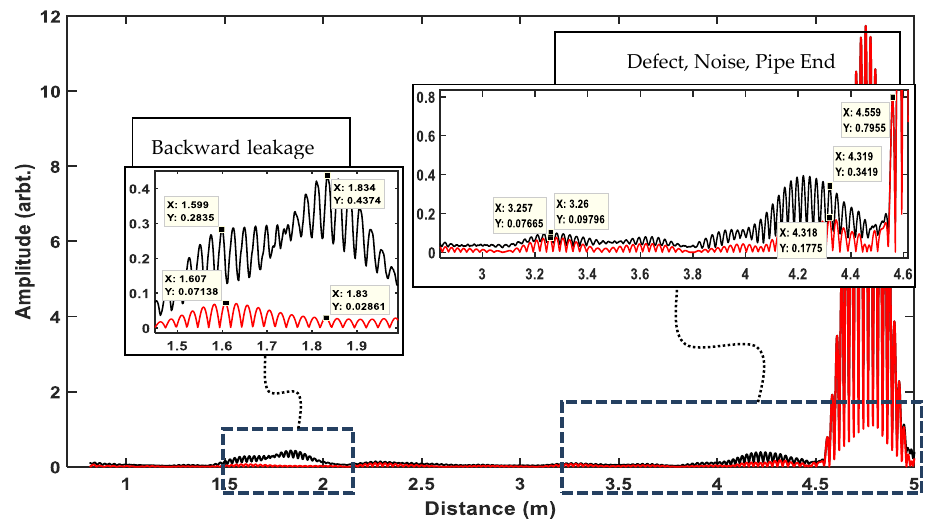
Figure 7. Comparison of the first and second thresholding versions on the Test 5 signal where the two zoomed regions are showing the backward leakage, defect, noise, and pipe end, respectively. The black and red signals are showing the first and second versions, respectively.